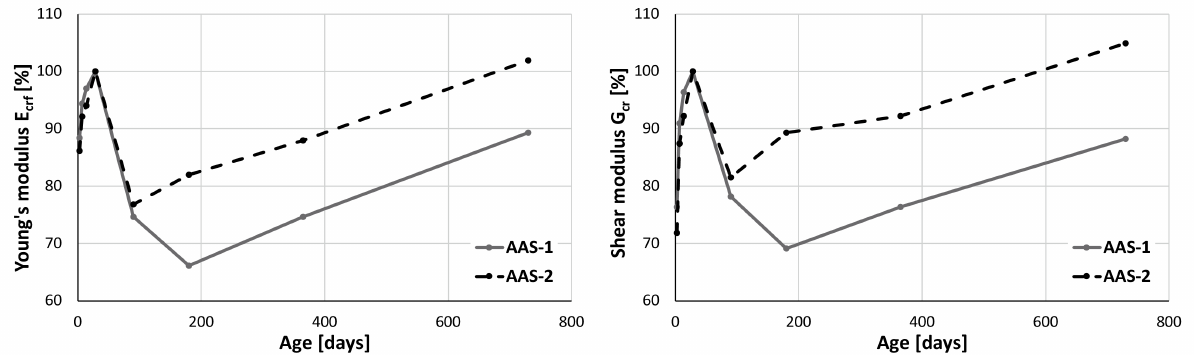
and E , the 28-day value represents 100%. cu crL